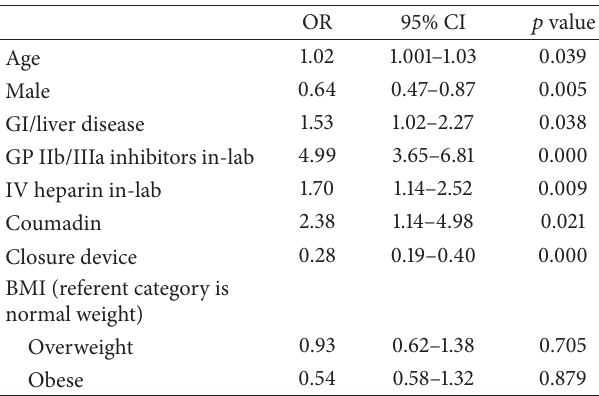
Table 6: Multivariate adjusted OR for nonvascular in-lab complica- tions in patients undergoing